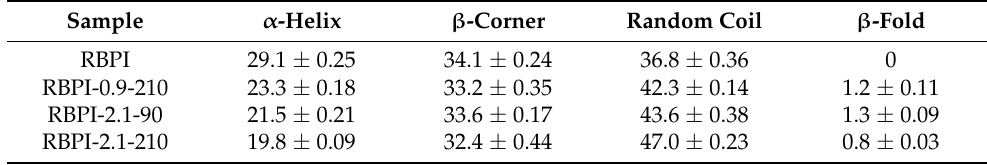
Table 4. Secondary structure content of RBPI prepared from different SFE pretreatment conditions (%).